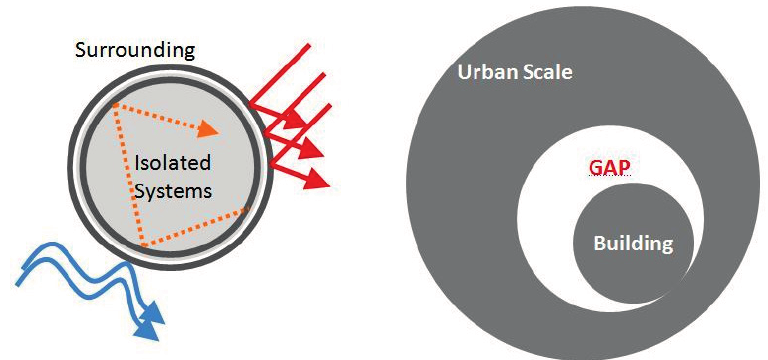
Figure 3. ( left ) Isolated system: the figure represents the aim/scope of traditional focus on energy efficiency; ( right ) The